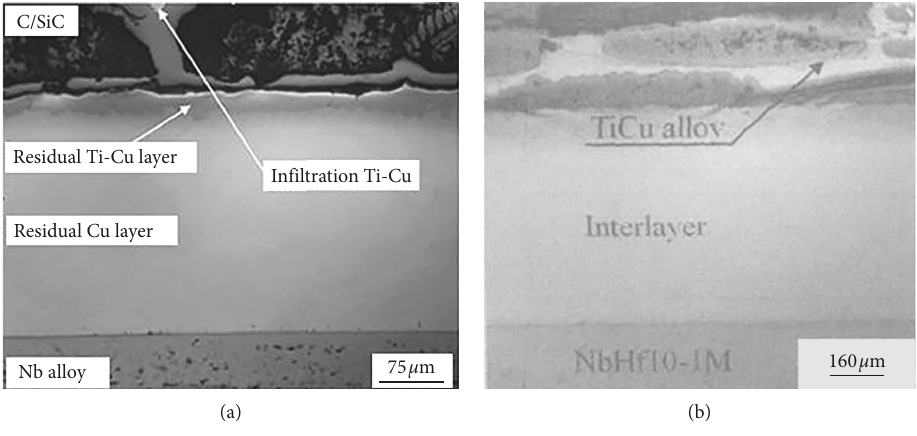
Figure 11: SEM micrograph of the joint: (a) 3D C